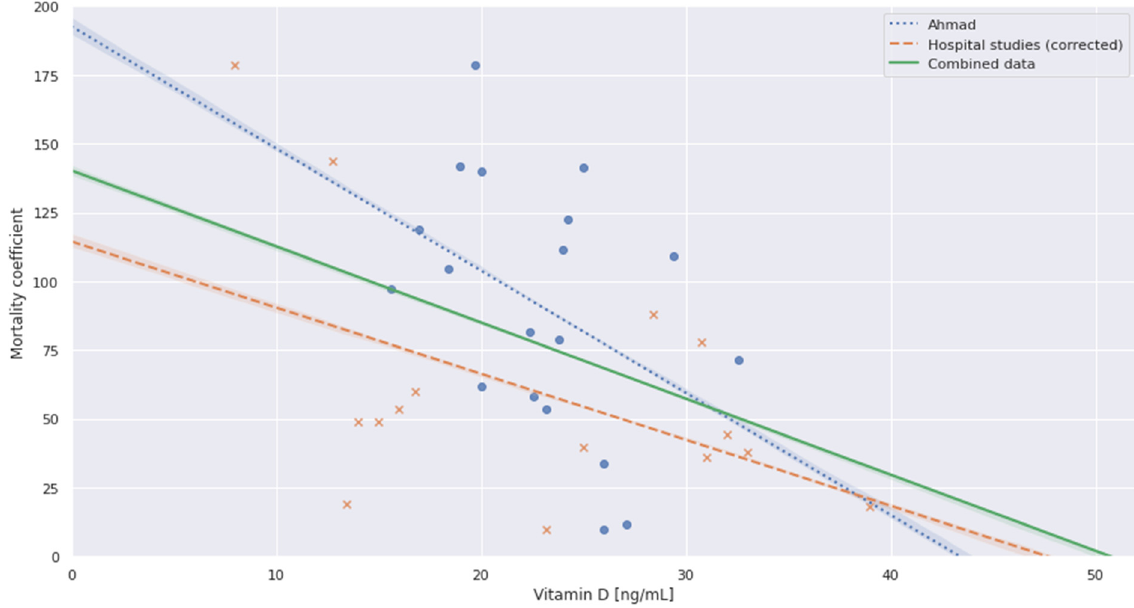
Figure 5. Scatter plot and OLS regressions of the individual and combined datasets.